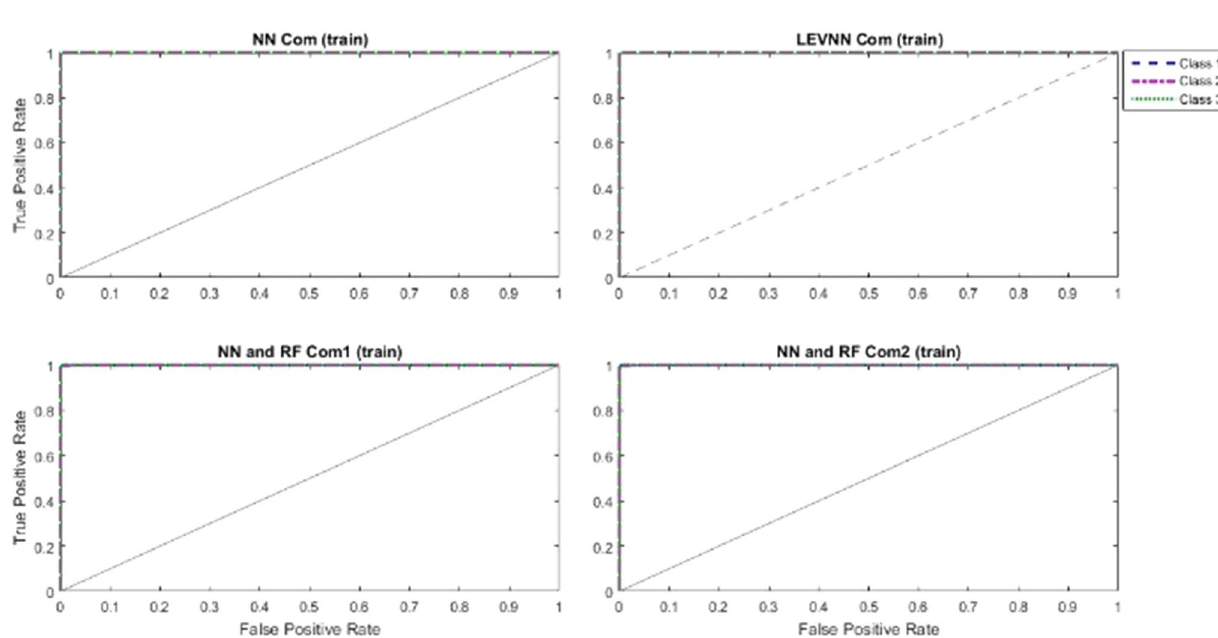
Fig. 14 ROC curve for the combined classifier (training)